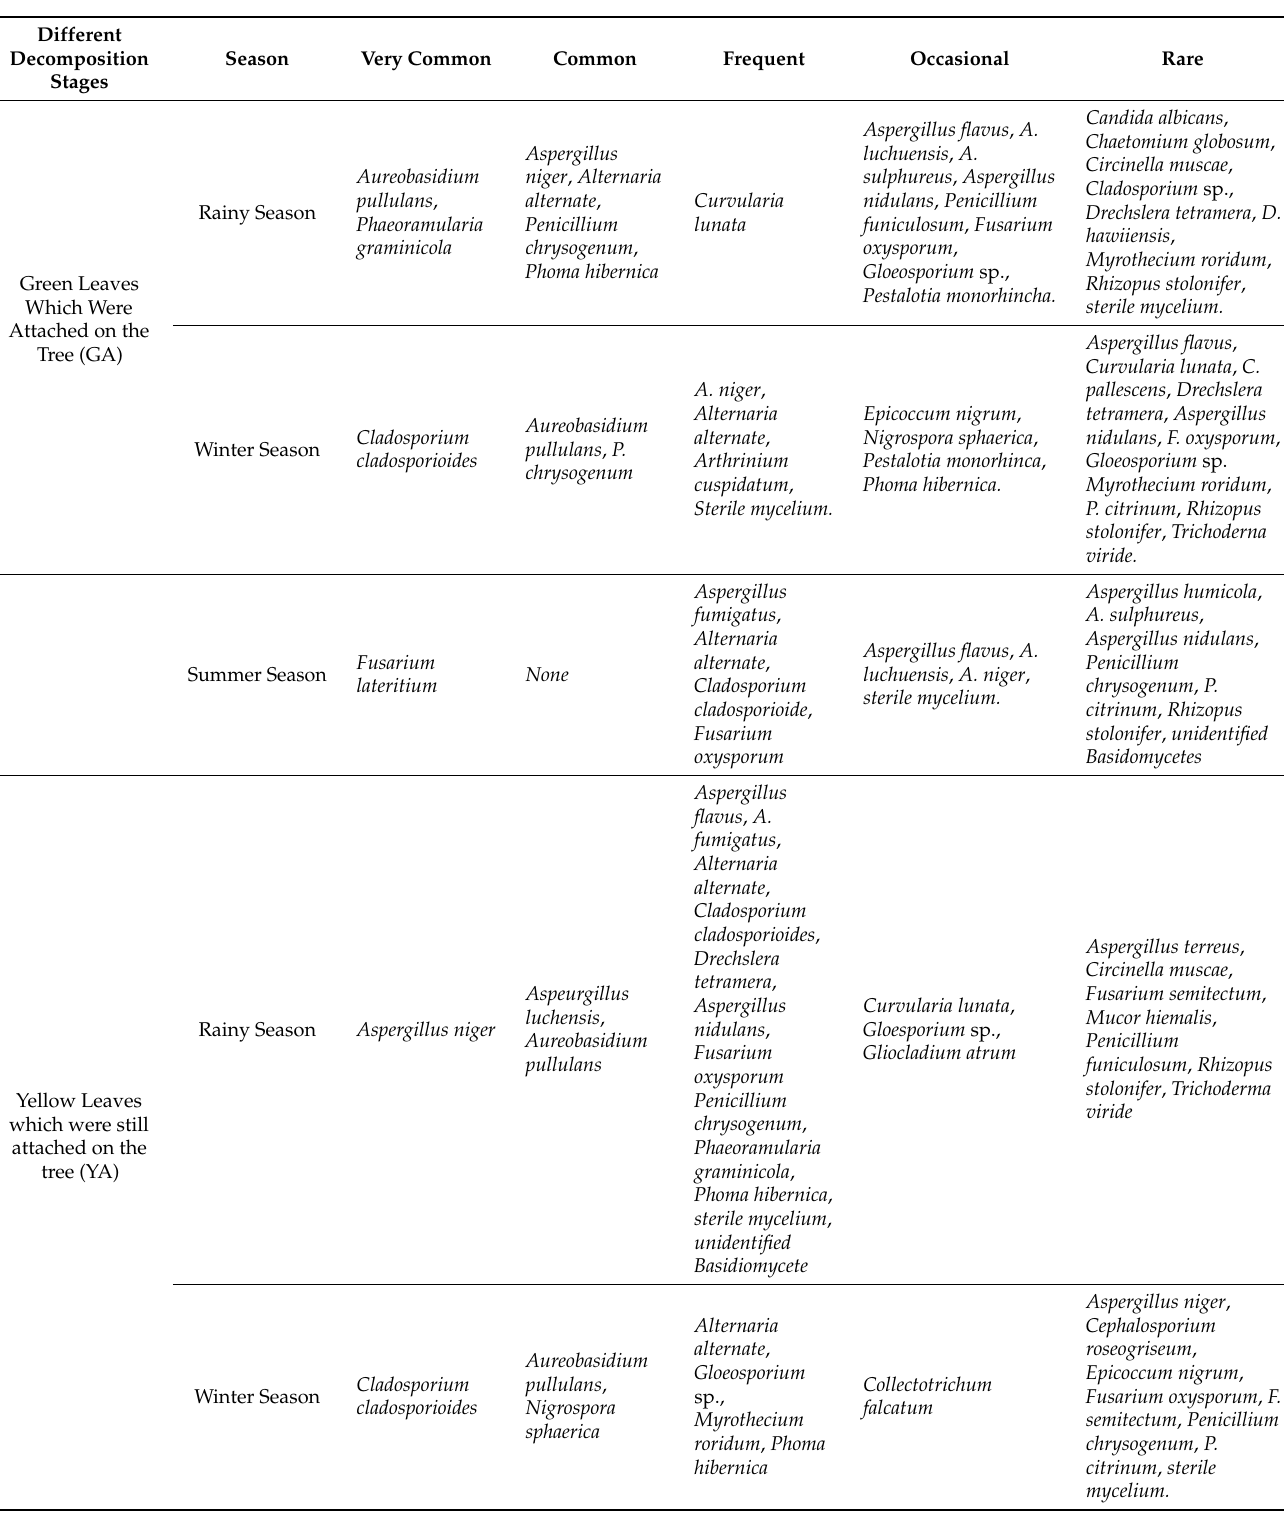
Table 8. Seasonal variation of various fungi at different decomposition stages of the